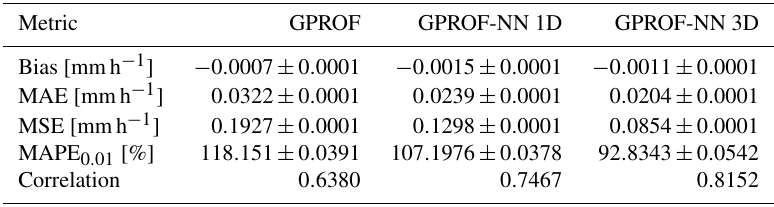
Table C1. The same as Table 4 but for convective precipitation.